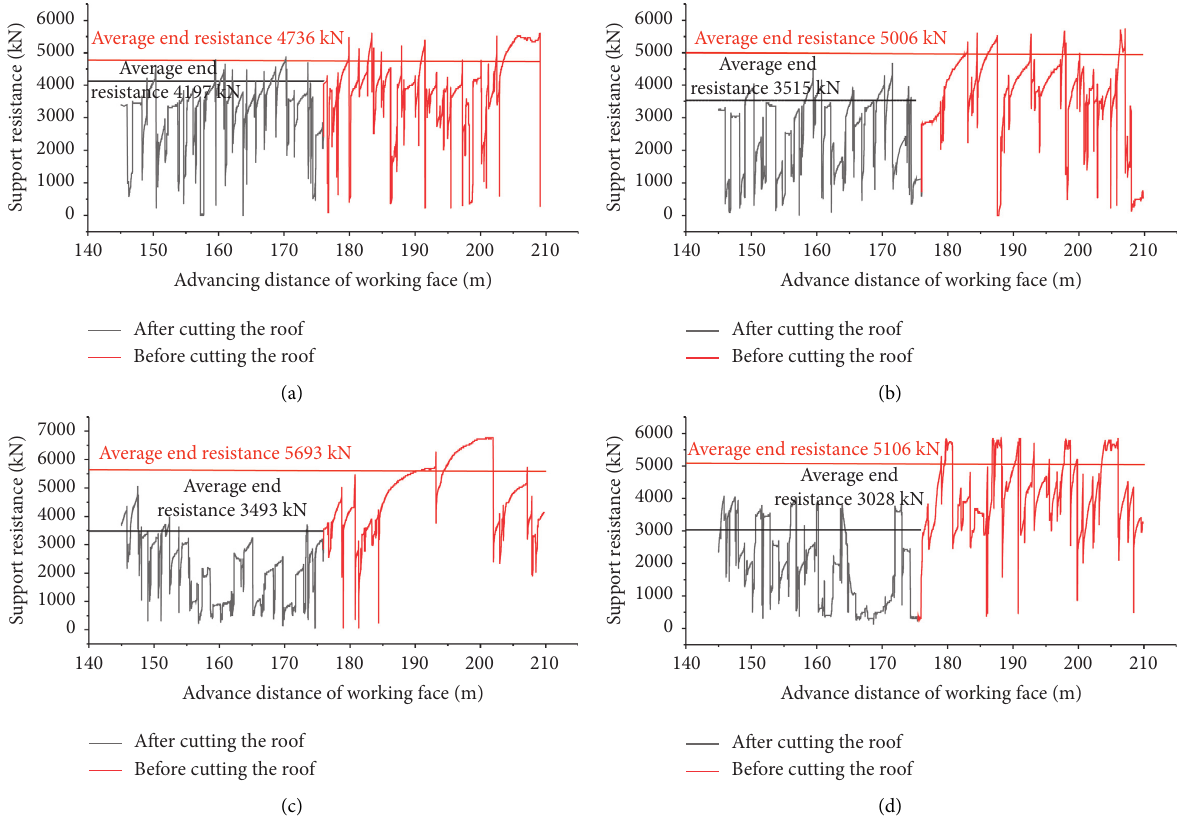
Figure 11: Measured curve of stent resistance. (a) No. 40 observation support. (b) No. 60 observation support. (c) No. 70 observation support. (d) No. 140 observation